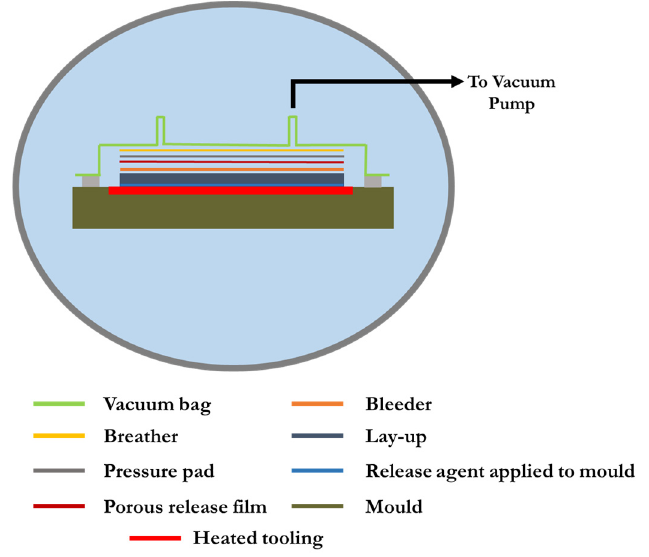
Figure 7. Schematic of cool-clave processing technique.